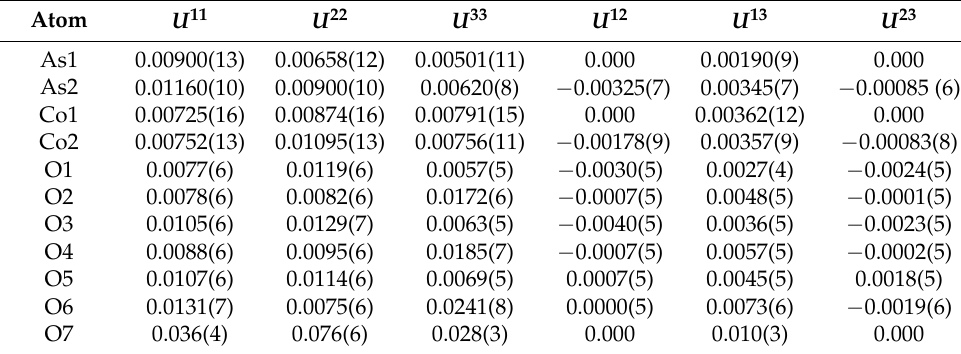
Table 3. Atomic displacement parameters (Å 2